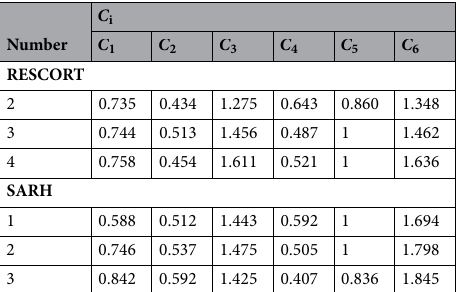
Table 10. Value of sub-capabilities C 1 ∼ C 6 with different equipment numbers.